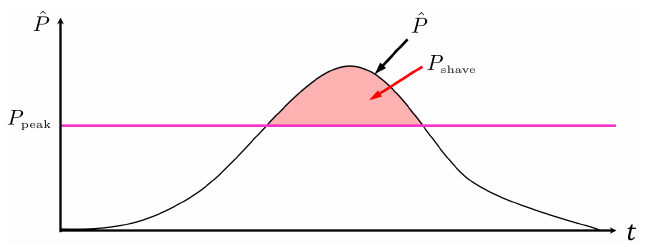
and P shave peak